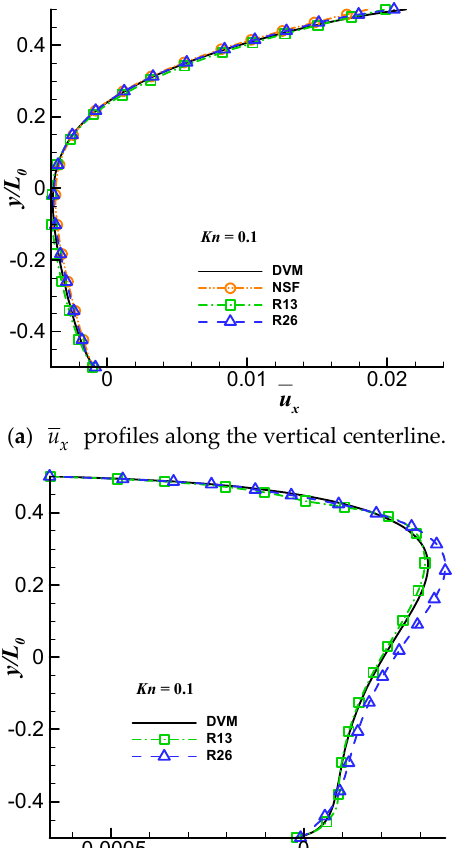
Figure 6. Comparison of the dimensionless VDFs f ,